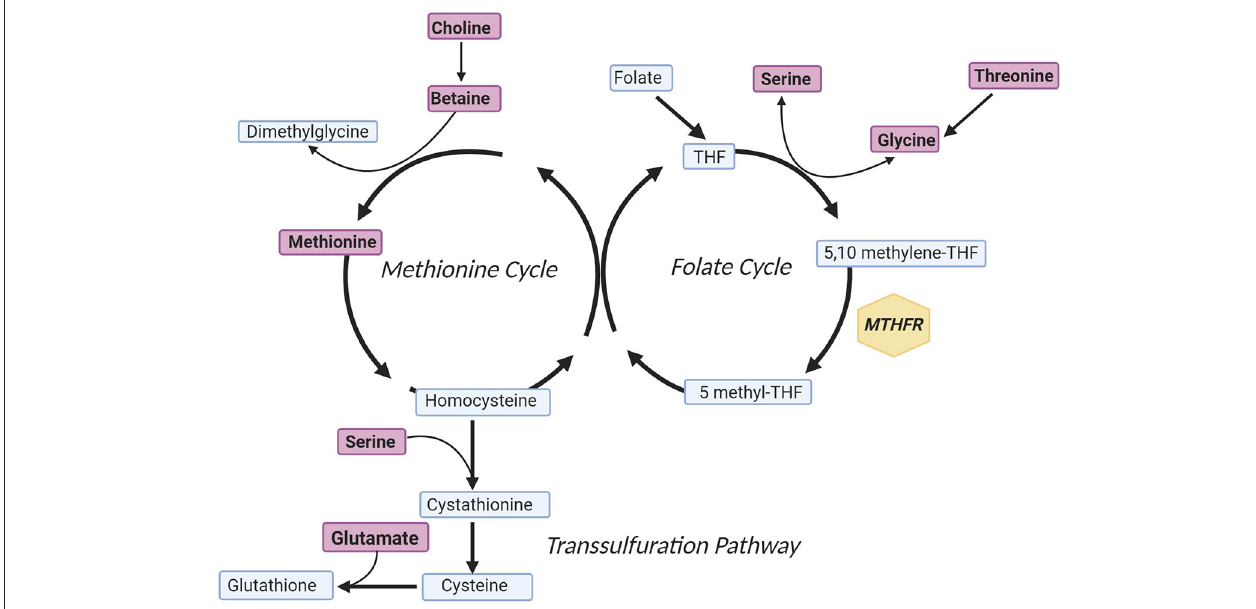
FIGURE 1 | Simplified One-Carbon Metabolism. Metabolites included in the model predicting log(HOMA-IR) concentration are indicated in purple, and the gene of interest is annotated within a yellow hexagon. In brief, the methionine cycle is involved in methyl-transferase reactions, the folate cycle is involved in purine synthesis, and the transsulfuration pathway culminates with formation of the antioxidant glutathione ( 9). The figure was created with Biorender.com. MTHFR, methylenetetrahydrofolate reductase; THF,